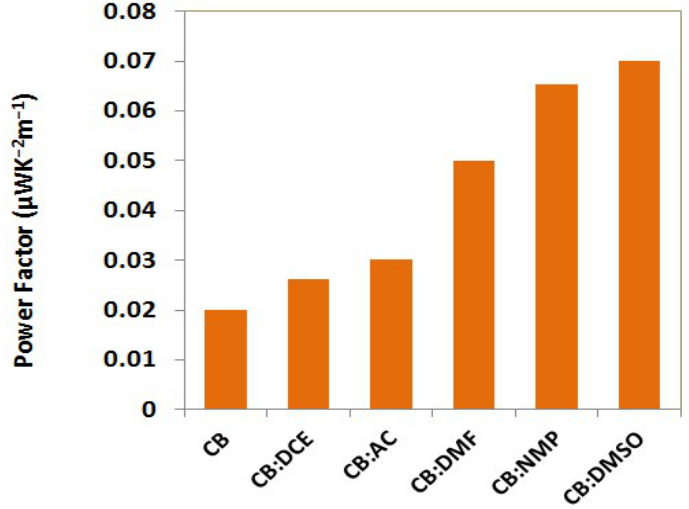
Figure 8. Thermoelectric power factor values of pristine and treated PCBM.